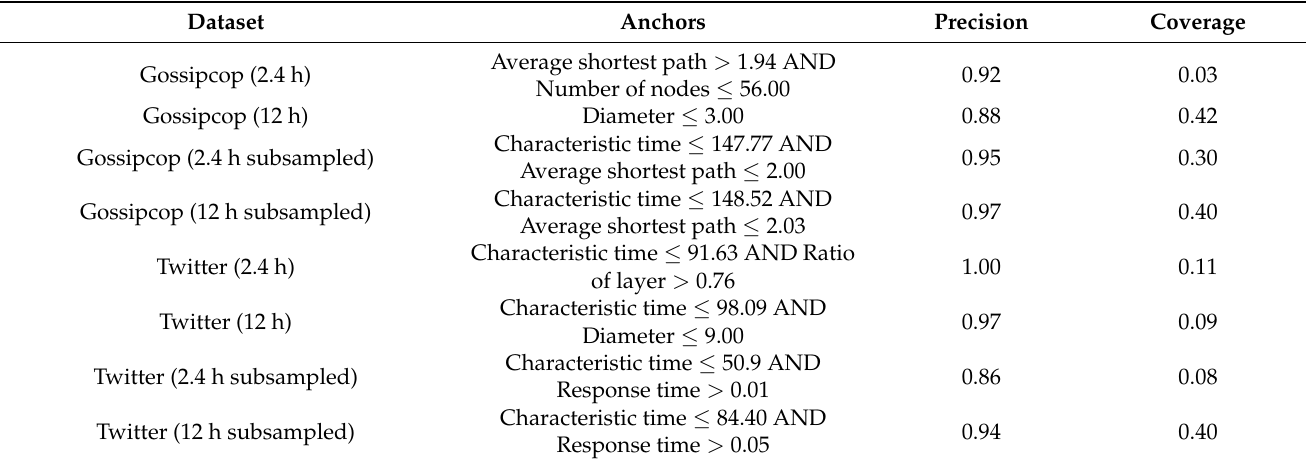
Table 4. Anchors